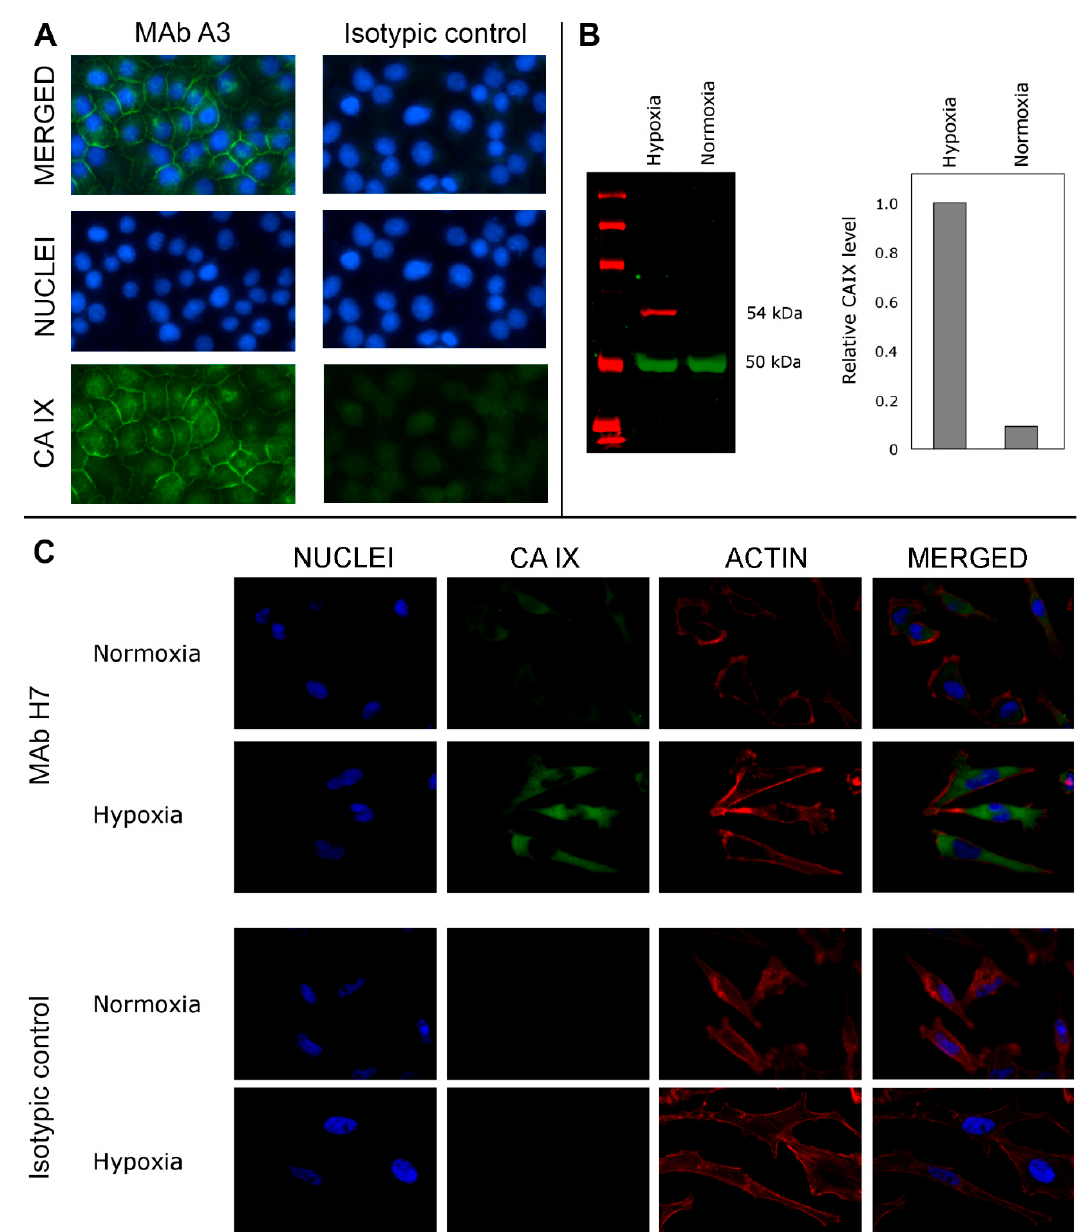
Figure 3. ( A ) Visualization of CA IX expressed in HeLa cells grown under hypoxia by immunofluorescence using anti-CA IX A3 and secondary anti-mouse IgG Alexa Fluor 488 antibody. Fluorescence microscopy images were taken at a × 20 magnification. ( B ) Characterization of anti-CA IX H7 using near-infrared fluorescence Western blot in triple-negative breast cancer cell line MDA-MB-231 cells under normoxic and hypoxic conditions. Human carbonic anhydrase IX was identified using MAb H7 at a dilution of 1:500. ( C ) Characterization of antibody H7 by immunofluorescence in MDA-MB-231 cells under normoxic and hypoxic conditions. CA IX was identified using MAb H7 and Alexa Fluor 488 conjugated goat anti-mouse IgG. Actin was stained using Alexa Fluor 568 Phalloidin, and nuclei were stained using DAPI. Fluorescence microscopy images of cells were taken at a × 63 magnification.